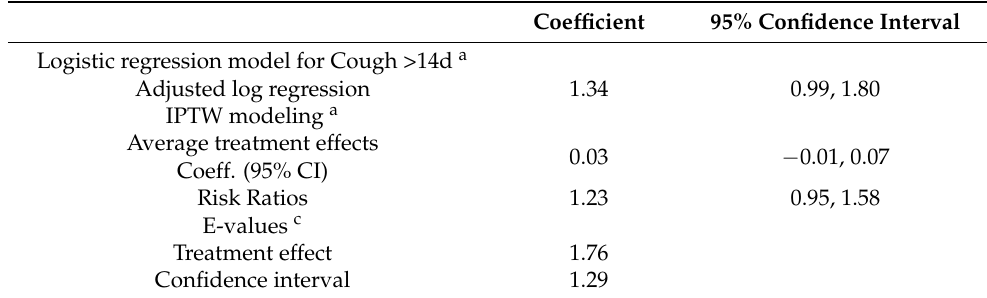
Table 2. Odds ratios, average treatment effects, and risk ratios for the relationship between caries progression and significant